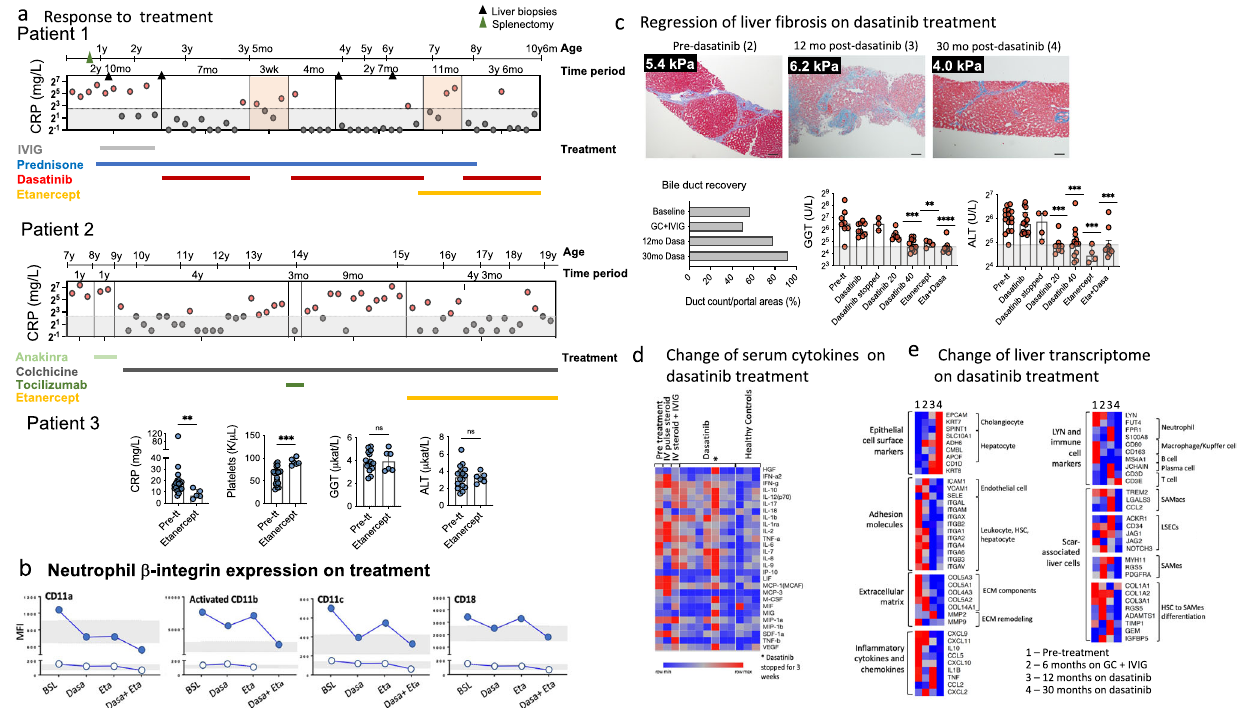
Fig. 4 | Response to treatment in the three patients with gain-of-function mutations in LYN . a Longitudinally obtained CRP levels are depicted for all patients strati fi ed by treatment. C-reactive protein (CRP), liver function tests (LFTs),gamma-glutamyltransferase(GGT),andalanineaminotransferase(ALT).For Pt.3 comparisons between pre-treatment (pre-tt) and post etanercept treatment (etanercept) samples were depicted in scatter plots with bar graphs showing median and interquartile ranges. For CRP: pre-tt n =28, etanercept n =5, p =0.0056; platelets, pre-tt n =28, etanercept n =6, p =0.0005; GGT, pre-tt n =15, etanercept n =6, p =0.9568; ALT, pre-tt n =16, etanercept n =6, p =0.9591. ** p <0.01, *** p <0.001 as determined by Mann – Whitney test with two-tailed